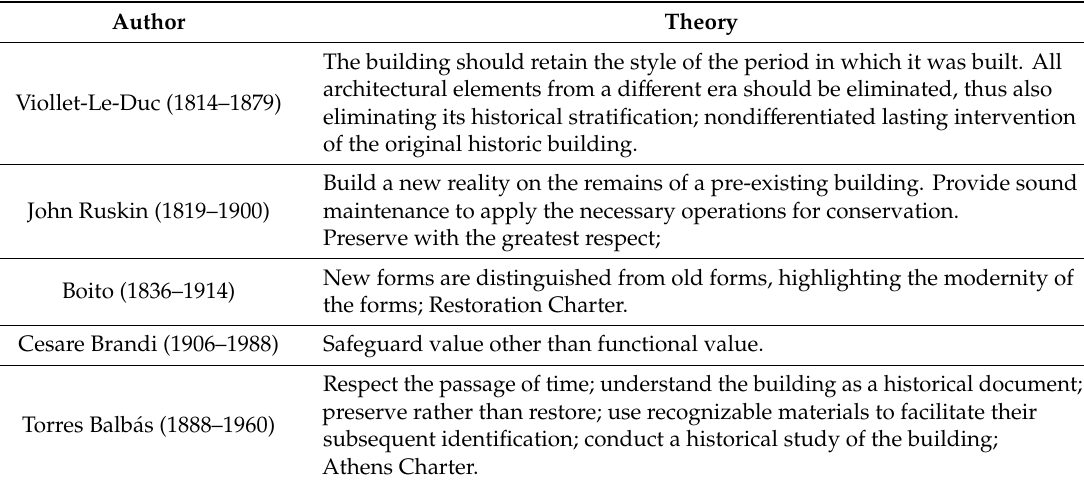
Table 1. Theories for the restoration of heritage assets